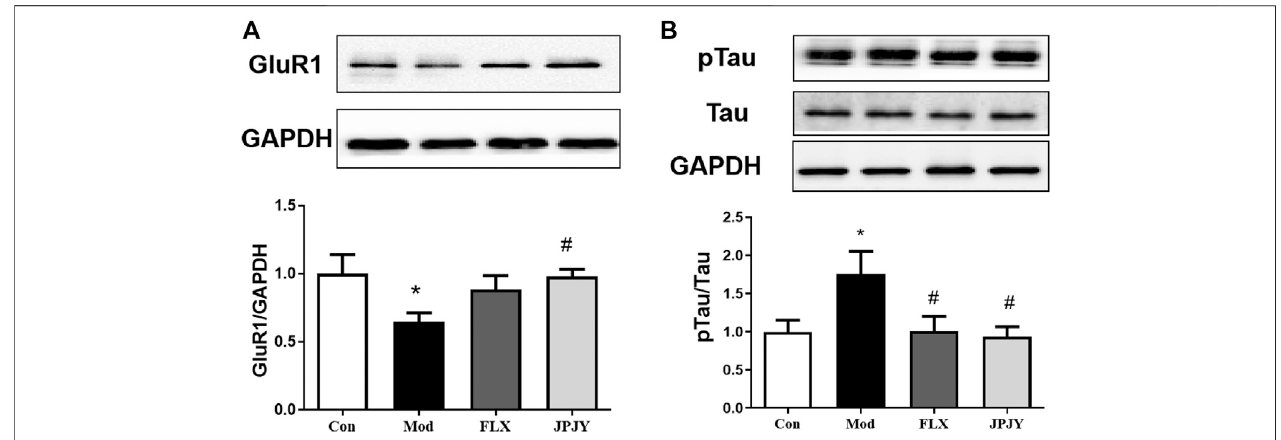
FIGURE 7 | The expressions of GluR1 and p-Tau/Tau in hippocampus were reversed in mice exposed to chronic mild stress. Mice were exposed to chronic unpredictable mild stress (CUMS), and received treatment of Veh (Vehicle), FLX, JPJY and QS. Control (Con) mice were not exposed to stress but received vehicle treatment. (A) The expression of Glur1 F (3, 13) (cid:2) 2.569; p (cid:2) 0.00993. (B) The expression of p-Tau/Tau, F (3, 11) (cid:2) 1.807; p < 0.05, n (cid:2) 4 – 5/group.